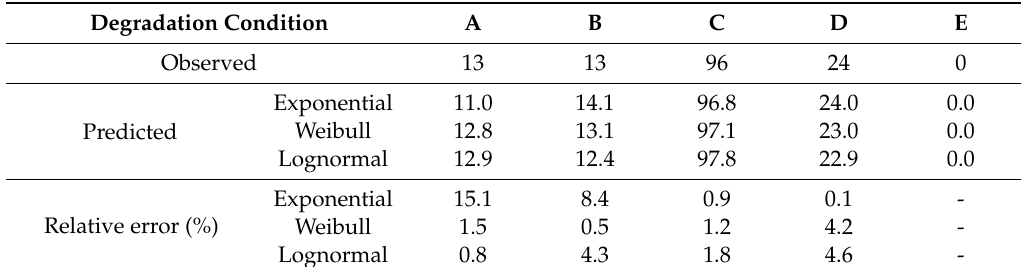
Table 3. Predicted and observed ceramic claddings in pitched roofs (CCPR) in the di ff erent degradation conditions, as well as the respective relative